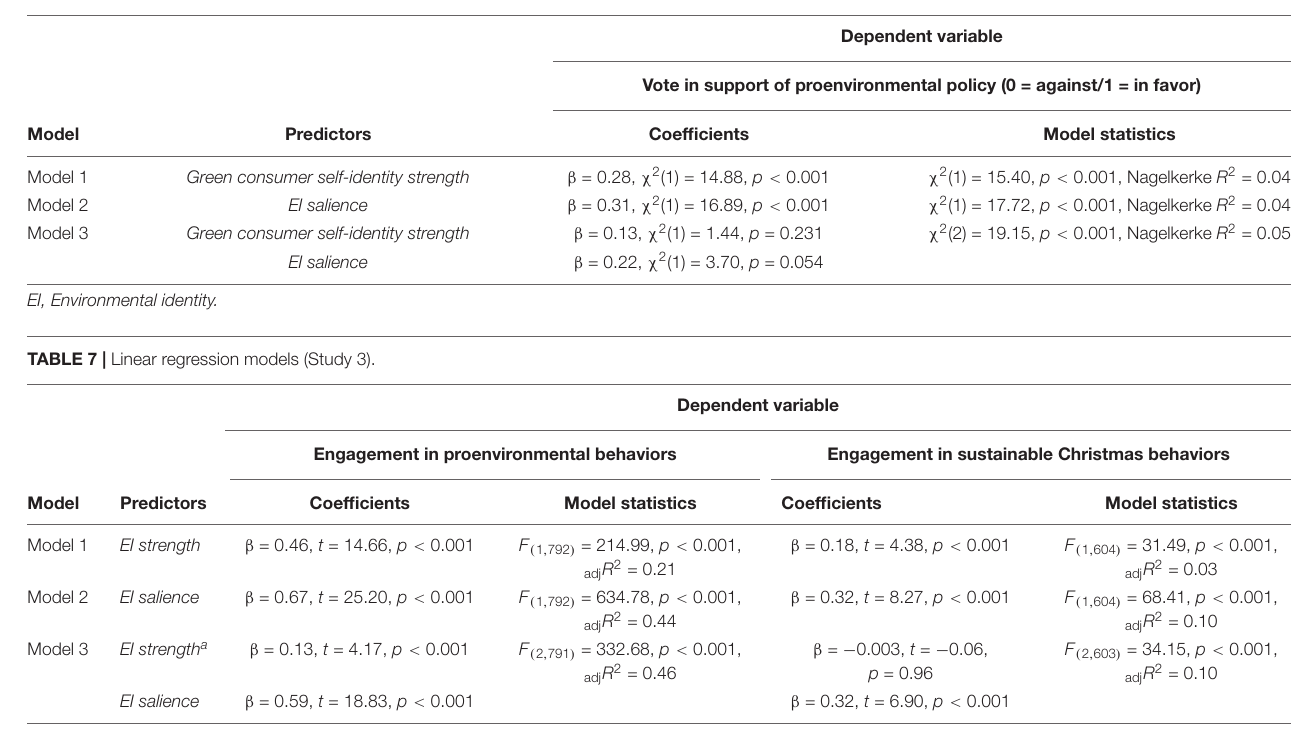
TABLE 6 | Logistic regression models (Study 3).